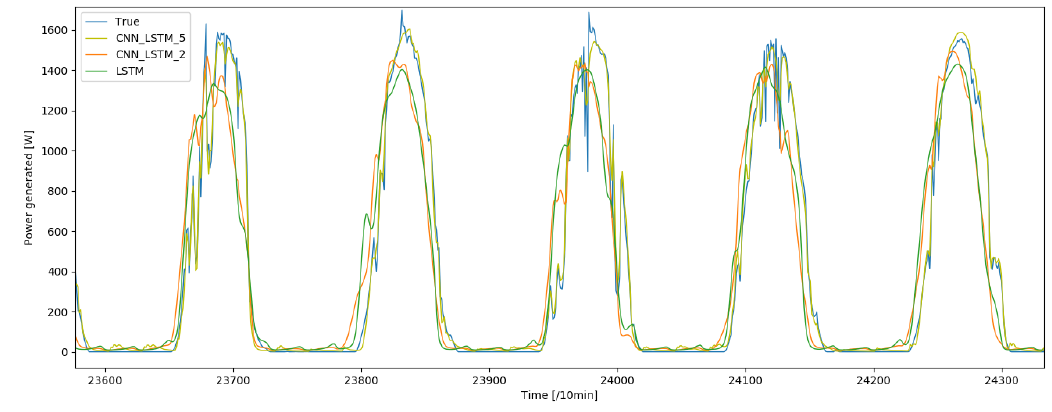
Figure 9. Prediction of PV generation during summer.